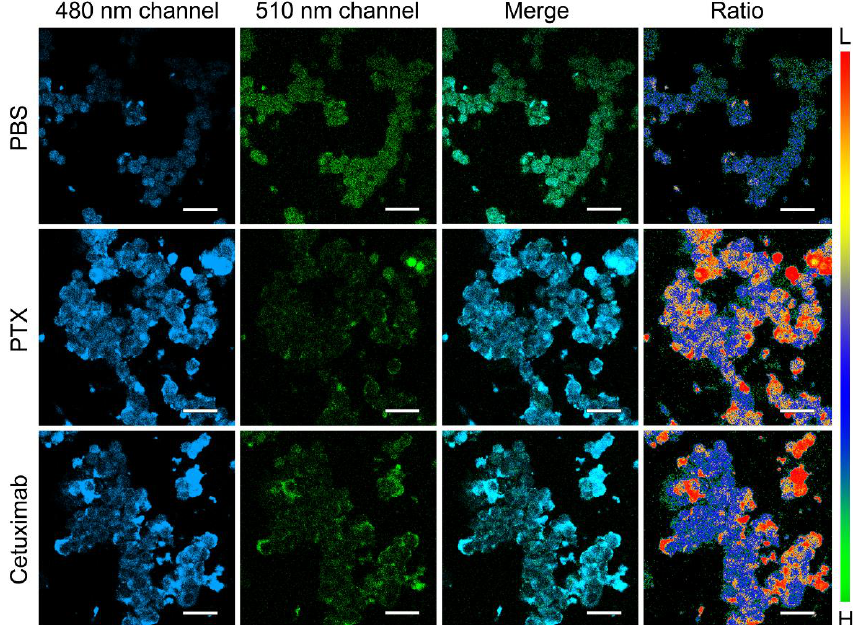
Figure 3. Fluorescence images (collected at 465 – 490 nm and 510 – 550 nm for two channels), merged images, and ratio images of LS180 cells incubated with TAT-ANNA upon further incubation with PBS, anti-cancer drug Paclitaxel Injection (PTX), and Cetuximab, respectively. The scale bars correspond to 10 μm.